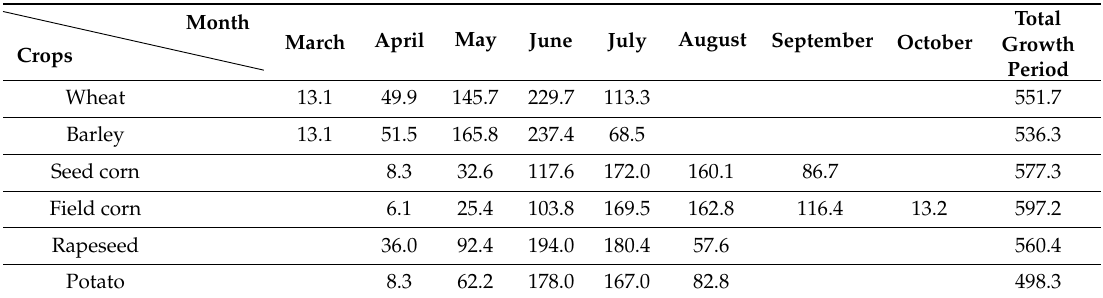
Table 4. ET c of main crops in the study area (unit: